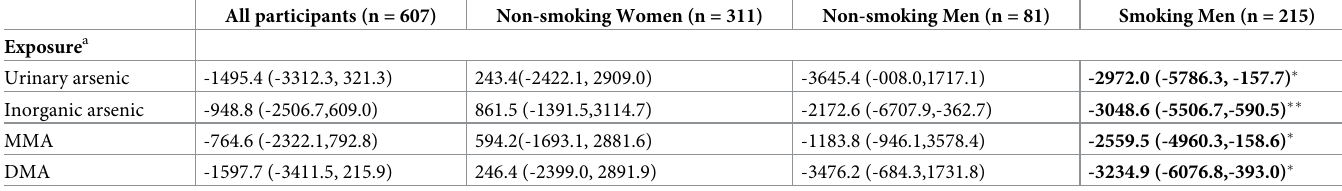
Table 2. Estimated coefficient of arsenic exposure in linear models for CD3-CD28 stimulated T cell proliferation. All participants (n = 607)